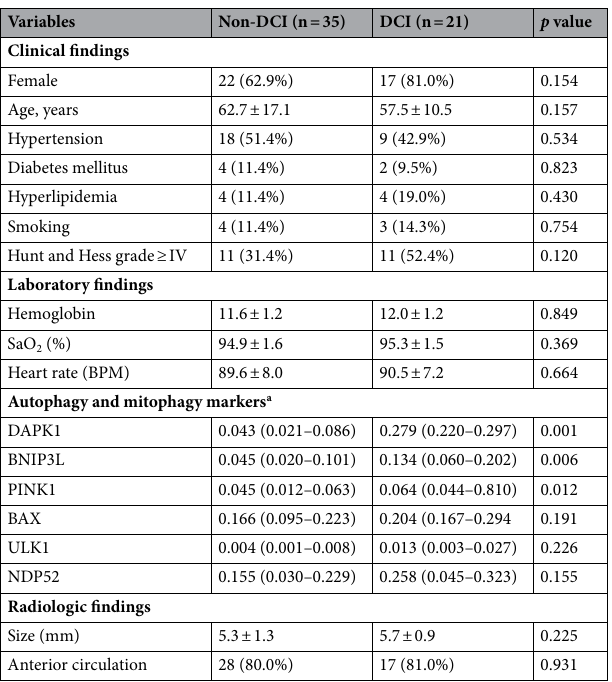
Table 1. Comparison of baseline characteristics of study subjects with and without DCI. BPM beats per minute, DCI delayed cerebral ischemia. a mRNA levels (2 −ΔCt ) of autophagy and mitophagy markers are presented as median and interquartile range.